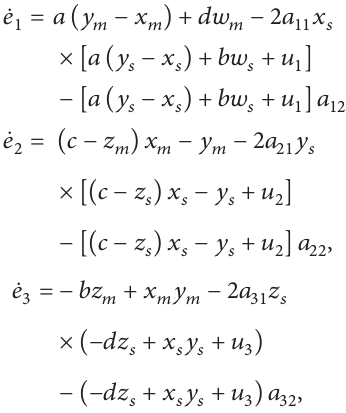
𝑧 1 (the dashed line) and